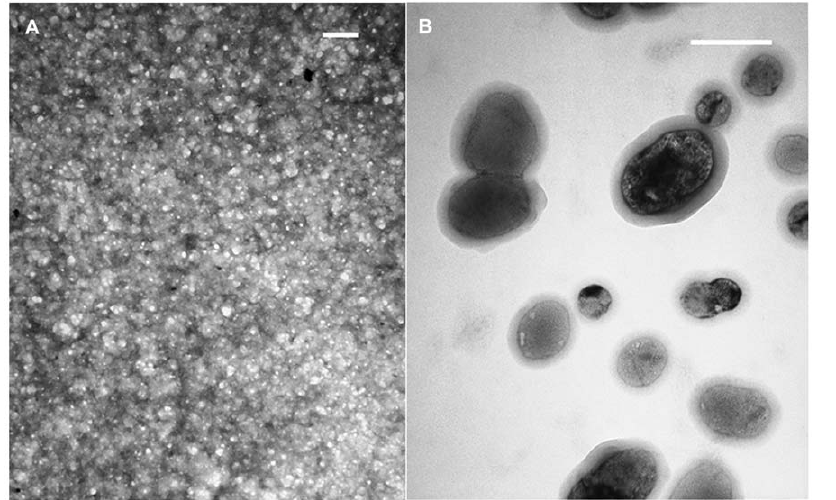
Figure 3. Transmission Electron Micrograph (TEM) of h 9 h 5 -vesicles. These peptides self-assemble into nano-sized vesicles. TEM images of (A) a concentrated and (B) a diluted sample of the peptide mixture, stained with 5% phosphotungstic acid and Osmium tetroxide (OsO4) vapors, respectively (200 nm scale bar).